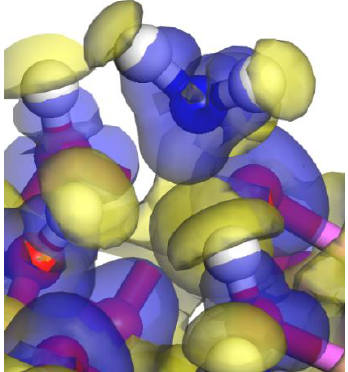
Figure 6. The electron density difference for the NH 3 molecule adsorption on the Kaolinite surface at the “Hollow1” adsorption site. The yellow region represents the accumulation of electrons, and the blue region represents the depletion of electrons (the white ball: H; the red ball: O; the blue ball: N; the purple ball: Al).